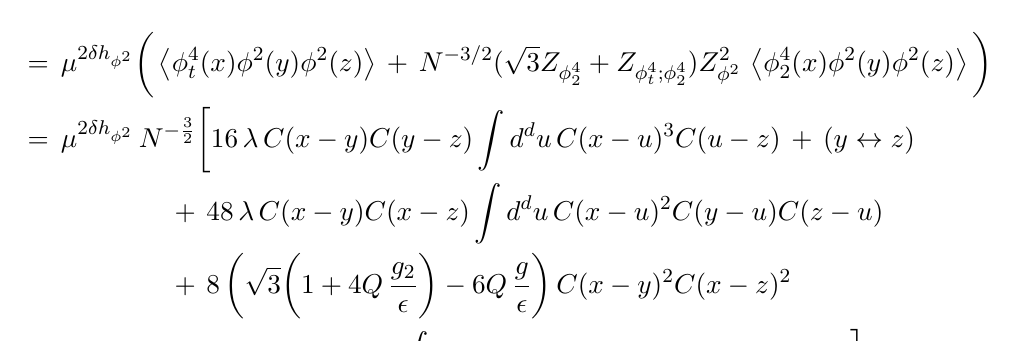
Figure 16 . Leading diagrams